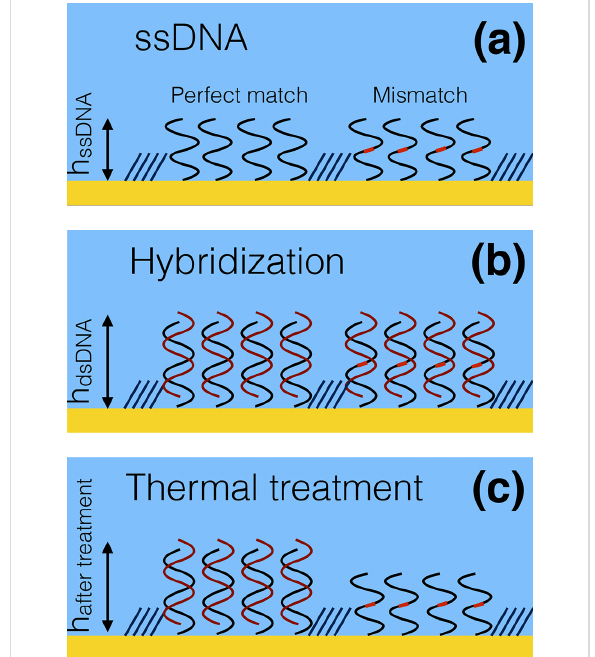
Figure 1: Schematics of the atomic force microscopy-based assay. We graft two sets of ssDNA nanostructures, whose sequences differ by one single base, highlighted by a red dot (panel a, b,c). By means of careful AFM topographic measurements, we record the height varia- tion over the ssDNA nanostructures, ( h ssDNA , panel a) upon hybridi- zation with a strand fully matching only the left grafted strand ( h dsDNA panel b), upon thermal treatment, ( h after treatment , panel c), evidencing the different de-hybridization behaviour of perfectly matched se- quences vs mismatched